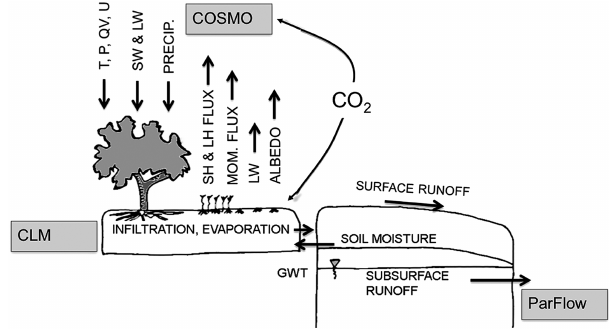
Figure 1. Schematic of interaction processes between TerrSysMP component